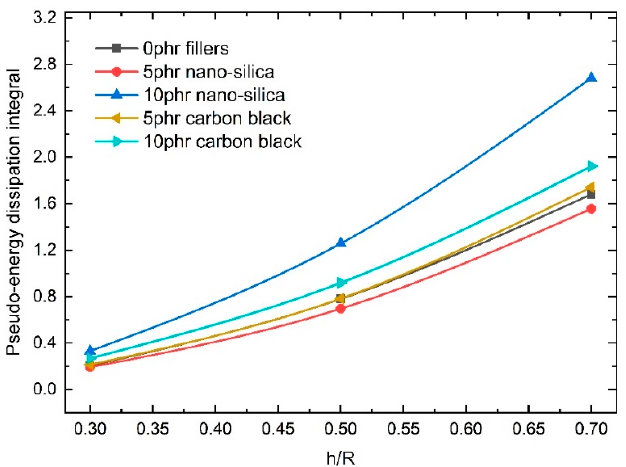
Figure 6. Integrals of the hysteresis loop areas from the compression tests.